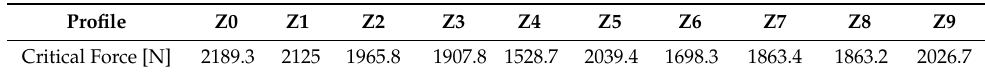
Table 3. The values of critical forces for all tested